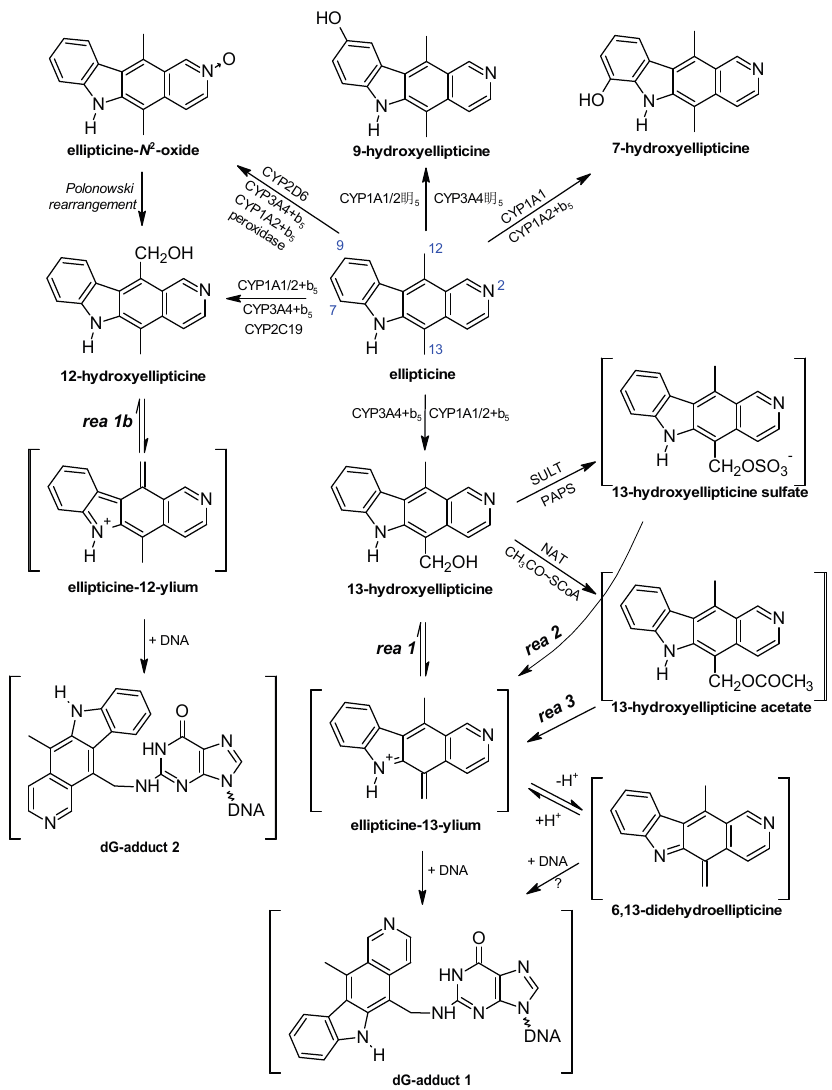
Figure 3. Ellipticine metabolism by CYPs showing the identified metabolites and those proposed to form DNA adducts. The compounds shown in brackets were not detected under the experimental conditions and/or are not yet structurally characterized.